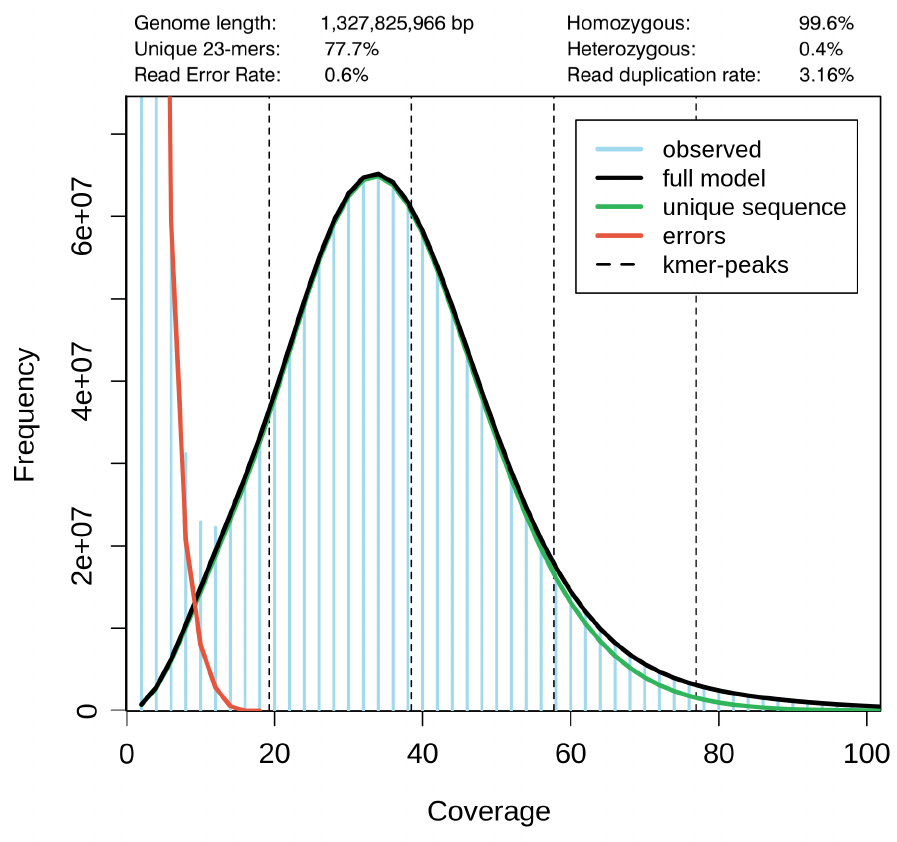
Figure 2. GenomeScope k-mer frequency plot for Darevskia valentini